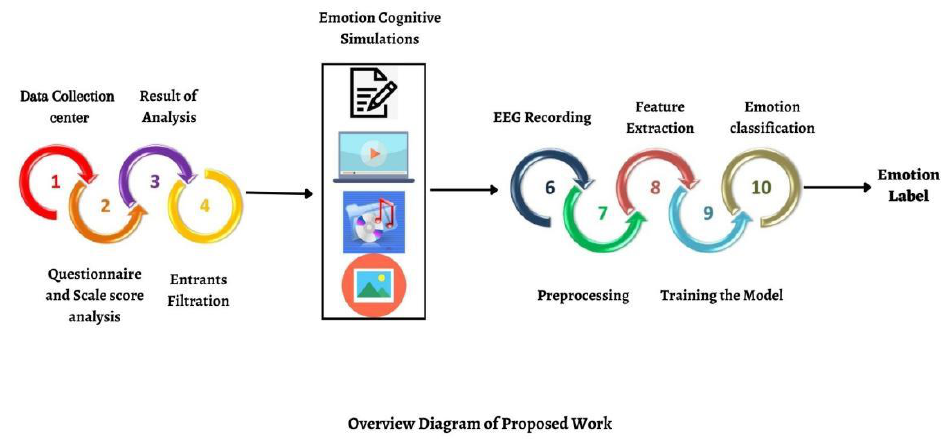
Figure 2. Block diagram of the work.